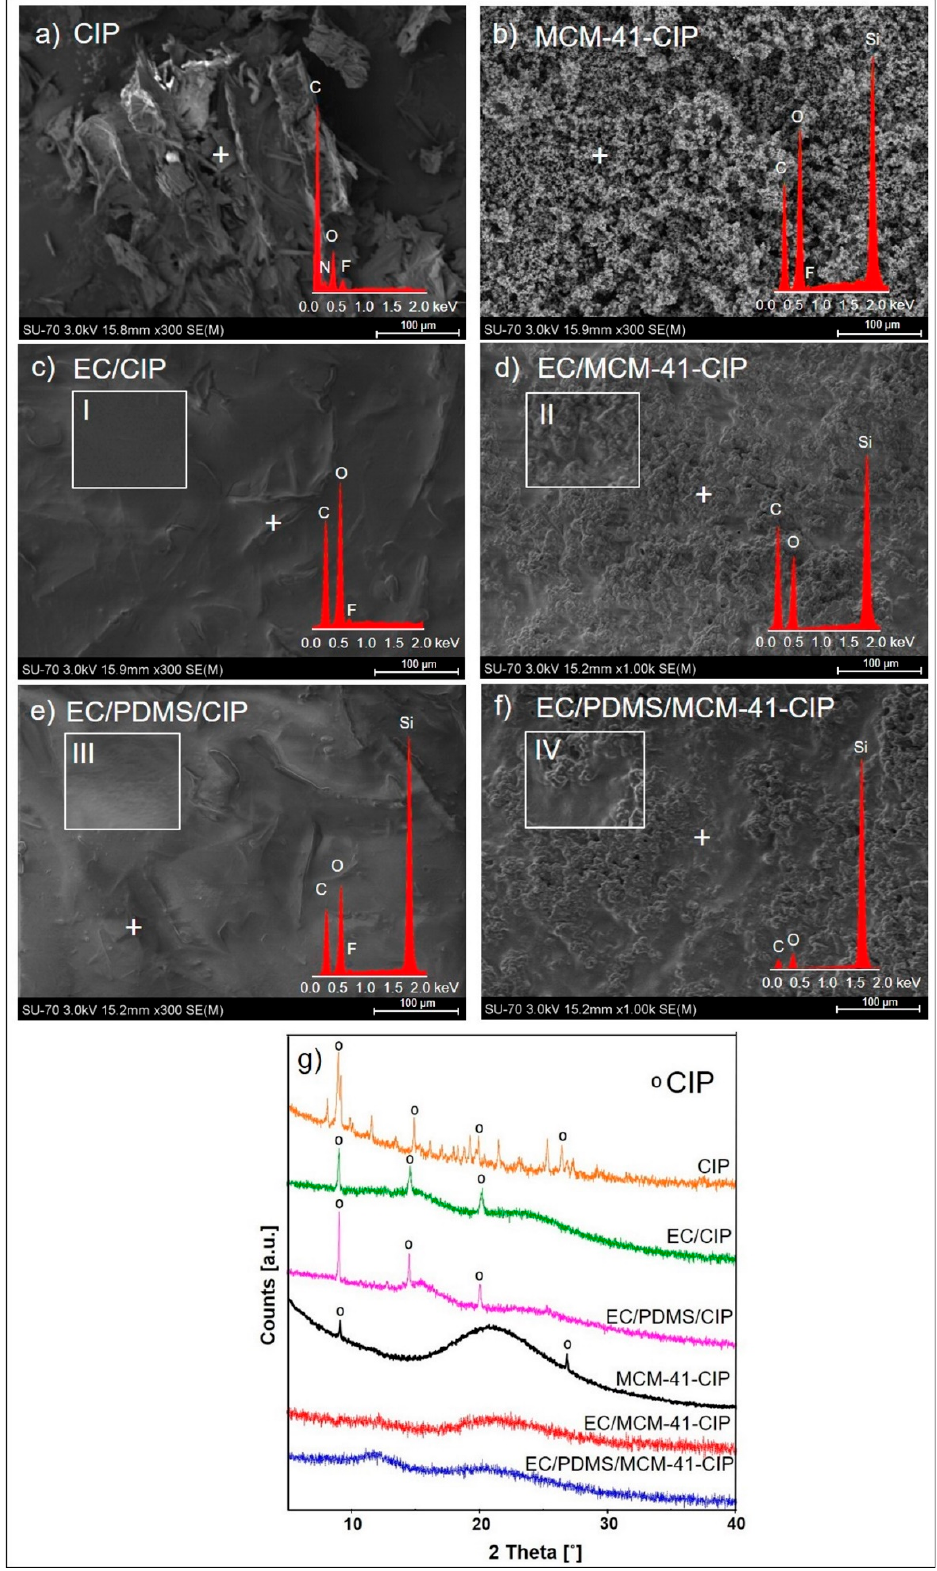
Figure 2. The SEM-EDX images of: freeze-dried CIP, MCM-41-CIP in the form of powders ( a , b ), SEM-EDX images of final composites: EC/CIP, EC/MCM-41-CIP, EC/PDMS/CIP, EC/PDMS/MCM-41-CIP ( c – f ) with high-magnification of composites surfaces (insets I–IV), and XRD patterns of each sample ( g ).